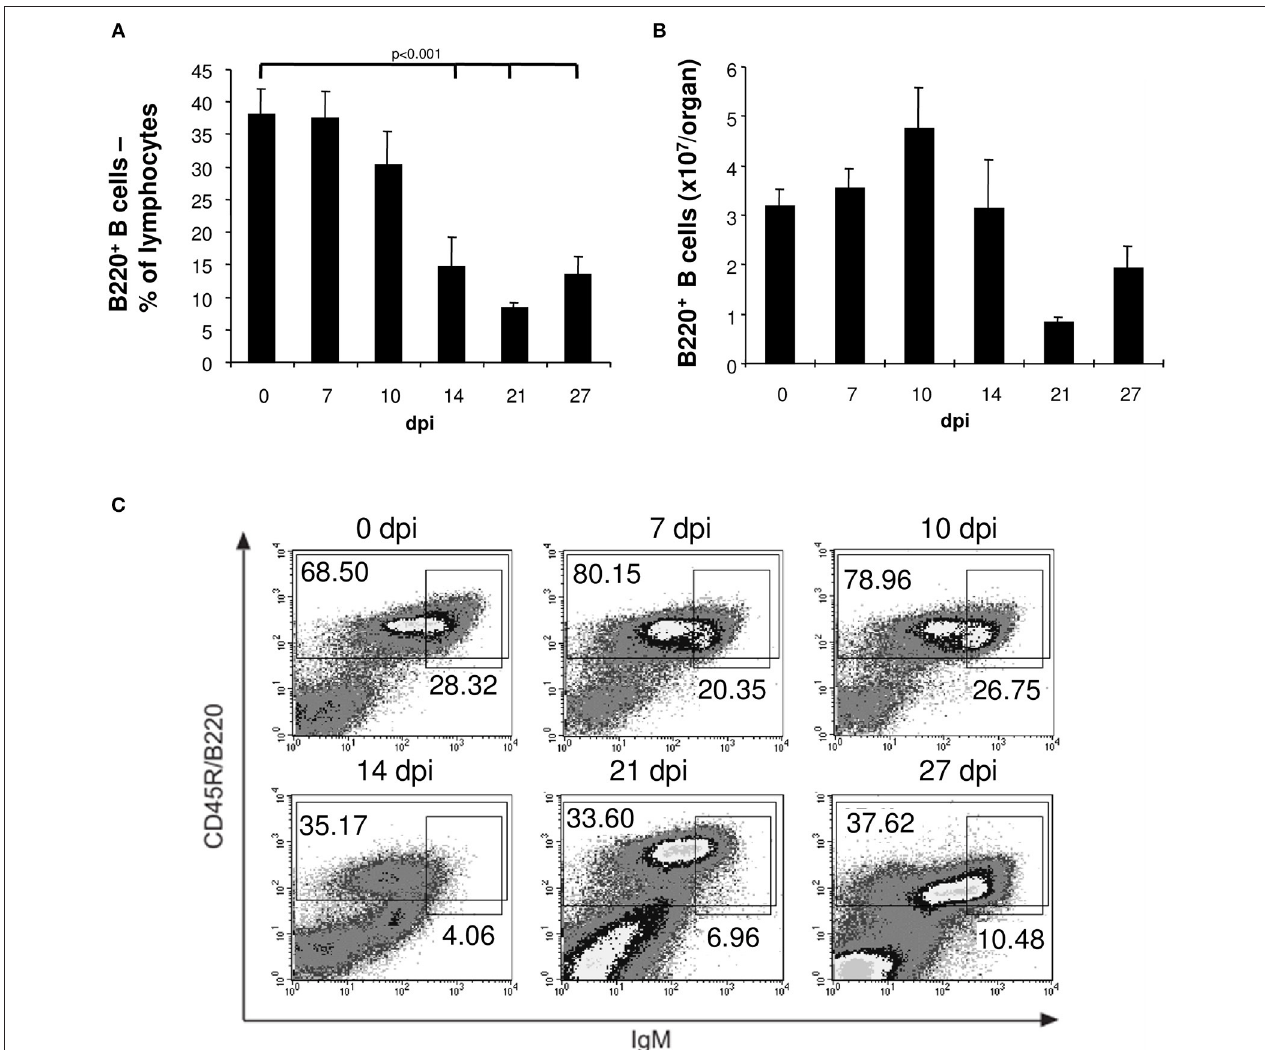
FIGURE 1 | Reduced numbers of mature and transitional B cells in spleens of T. cruzi -infected mice. C57BL/6 mice were infected with 75 T. cruzi blood trypomastigotes i.p. (infections with 500 T. cruzi blood trypomastigotes show comparable results). At the indicated time points, spleen cells were analyzed by flow cytometry. (A) Frequency and (B) absolute numbers of B220 + B cells. (C) Representative flow cytometric analysis of mature B220 + IgM dull and transitional immature B220 + IgM hi B cells. Data represent mean ± SD of pooled results from three independent experiments each comprising 5 mice per time point. Statistical analysis was performed using two-tailed Student’s t